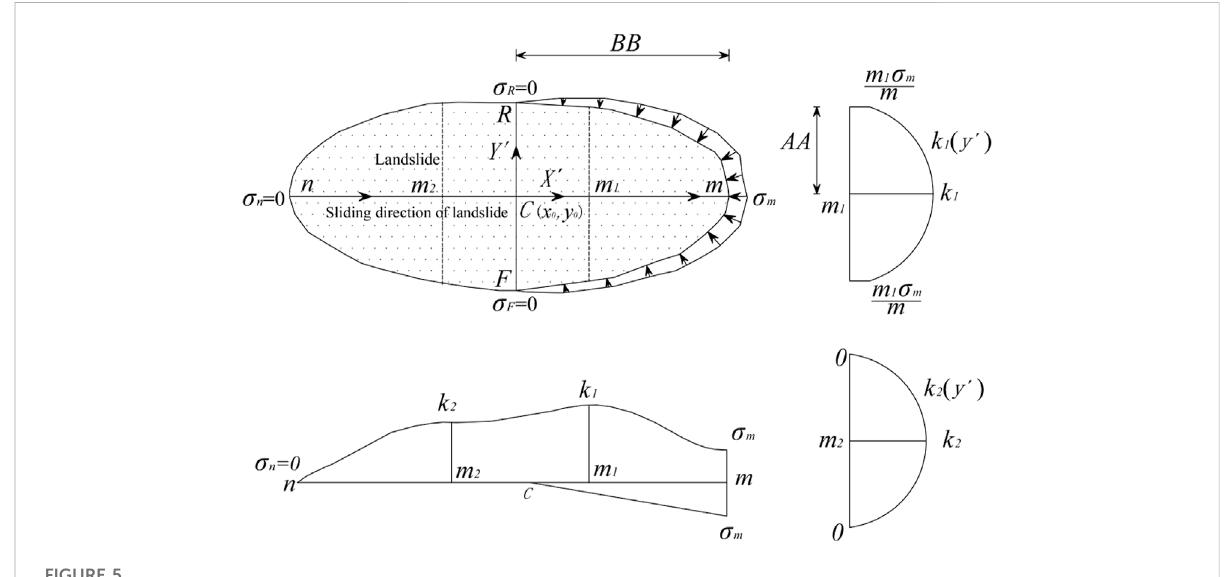
FIGURE 5 Normal stress assumption on the slip